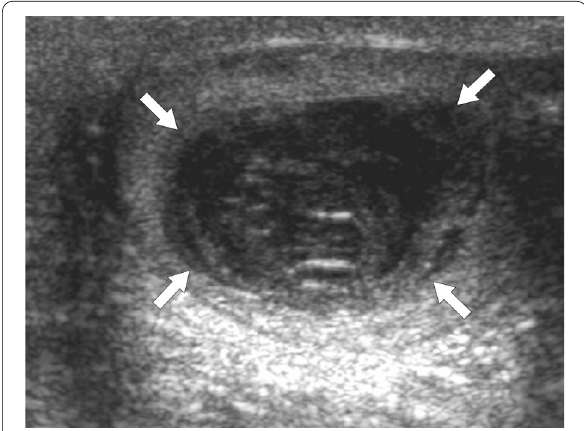
Fig. 11 Testicular vasculitis. A 37-year-old male with known Churg-Strauss disease now presenting with new testicular mass. The patient was afebrile and did not report any pain. Ultrasound image demonstrates focal well-defined hypoechoic, centrally cystic mass, almost completely replacing the left testis (arrows). Orchiectomy revealed necrotizing vasculitis with no malignant